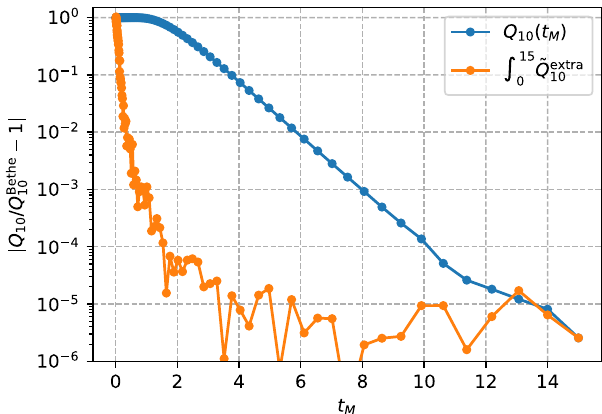
FIG. 14. Relative error with respect to the Bethe ansatz for R R ˜ ˜ 15 t M Q 10 ð t Q 10 and Q extra 10 , versus t 0 0 M Þ ¼ ˜ Q 10 obtained for v extrapolation of the TCI of Gauss-Kronrod rule with 63 points for the integration. The error saturates at 10 − 5 due to the discretization error. − 2 ; − 4 . d ¼